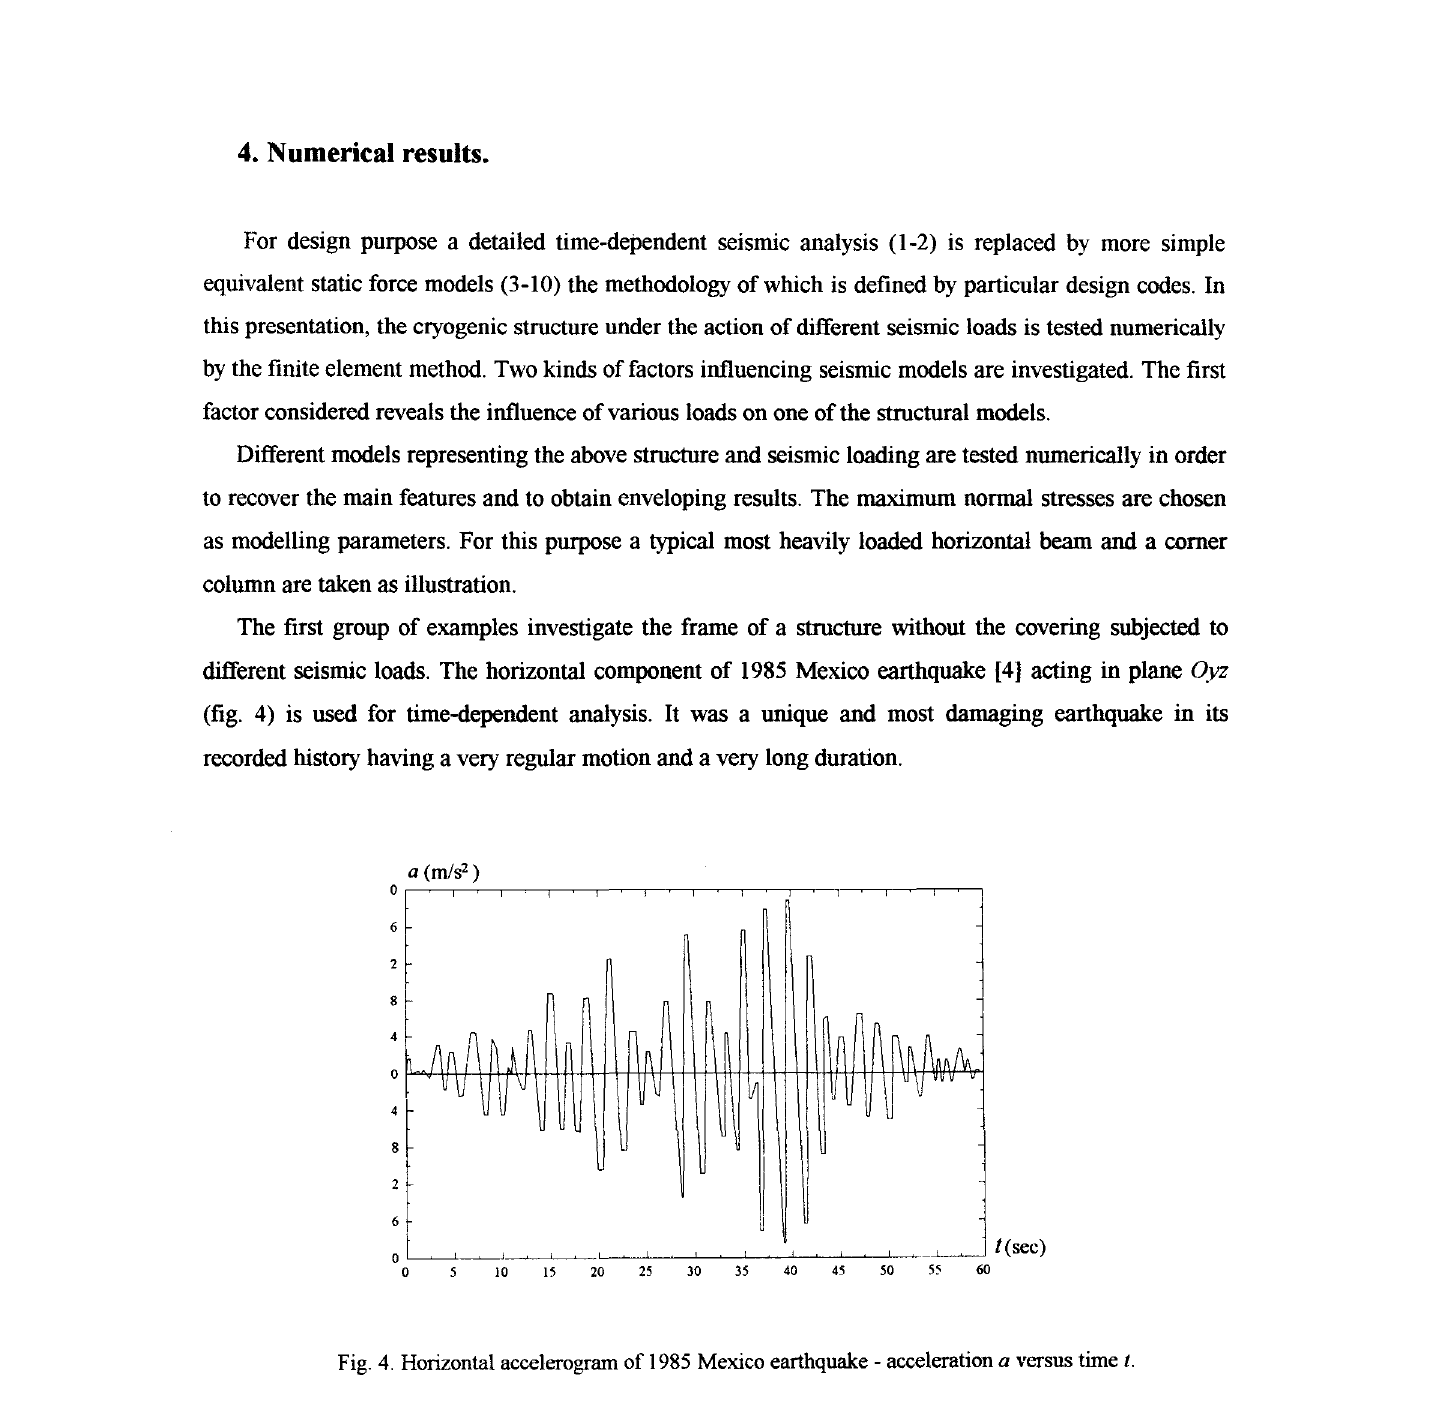
Fig. 4. Horizontal accelerogram of 1985 Mexico earthquake- acceleration a versus